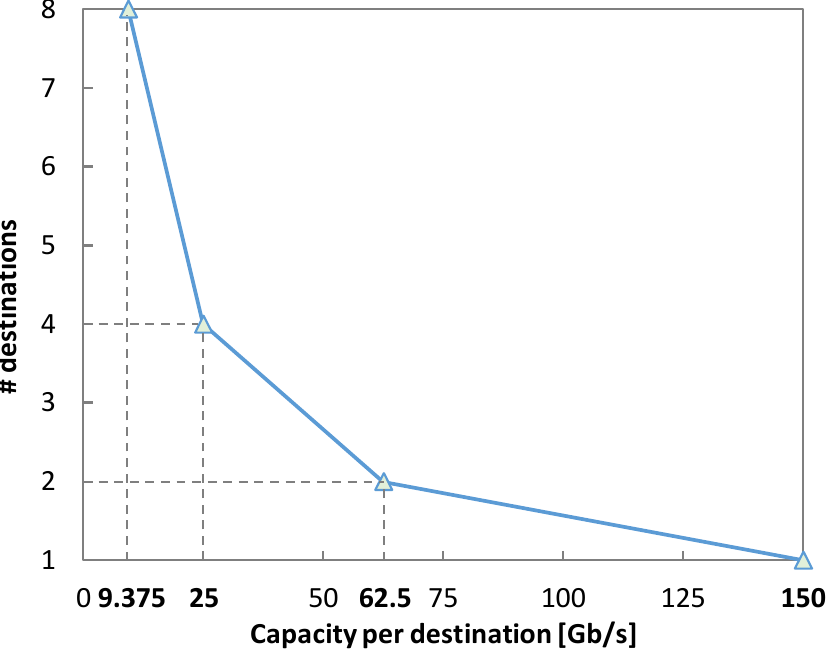
Figure 14. Reconfigurability options in OCS + DSCM.